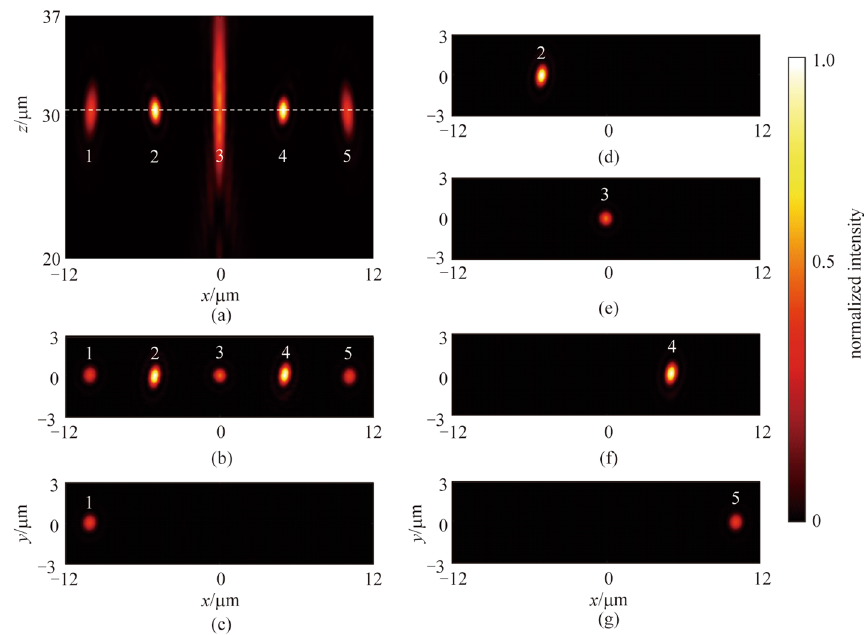
Fig. 7 Characterization of the metalens molecule designed for the LCP light. a Normalized intensity distribution at the xz section. b Normal- ized intensity distribution at the focal plane when all the metalenses are illuminated. c – g Normalized intensity distributions of the focal plane when each target metalens is illuminated, respectively. All the intensity distributions are normalized by the maximum intensity of the metalens molecule designed for the LCP